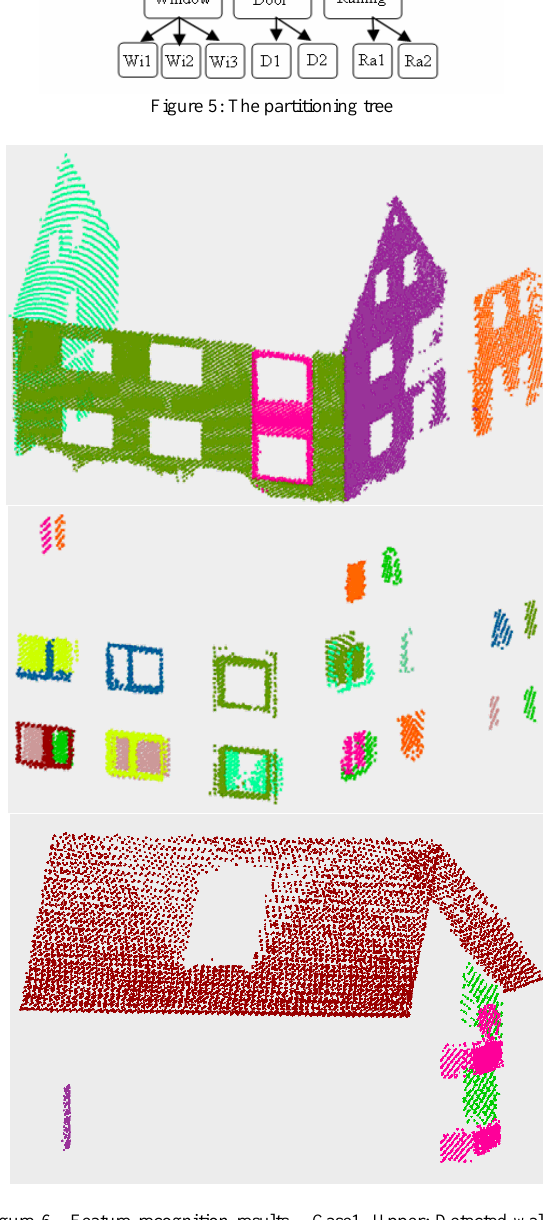
Figure 6. Feature recognition results – Case1. Upper: Detected walls; Middle: Detected windows; Lower: Detected roofs (brown), railings (pink), sidewalls (green) & doors